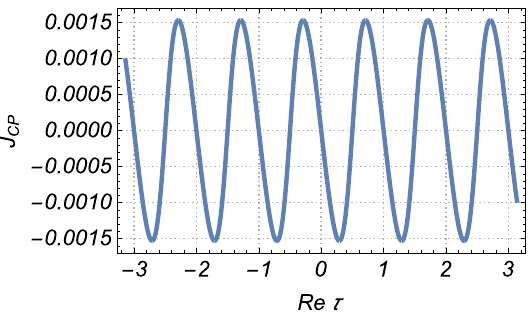
Figure 2 . The relationship between a real part of the complex structure modulus Re τ and the Jarlskog invariant J CP in Sample III.